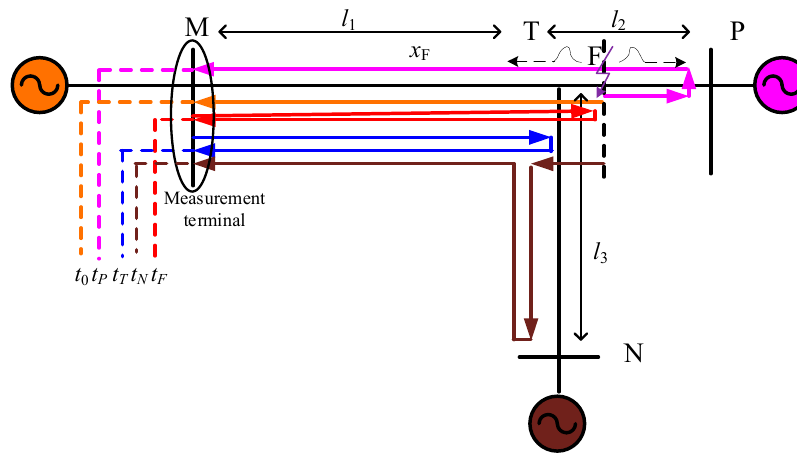
Figure 5. Travelling wave propagation path in section TP.